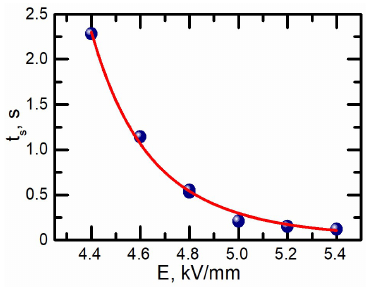
Figure 3. The field dependence of the switching time measured during polarization reversal without artificial dielectric layer.